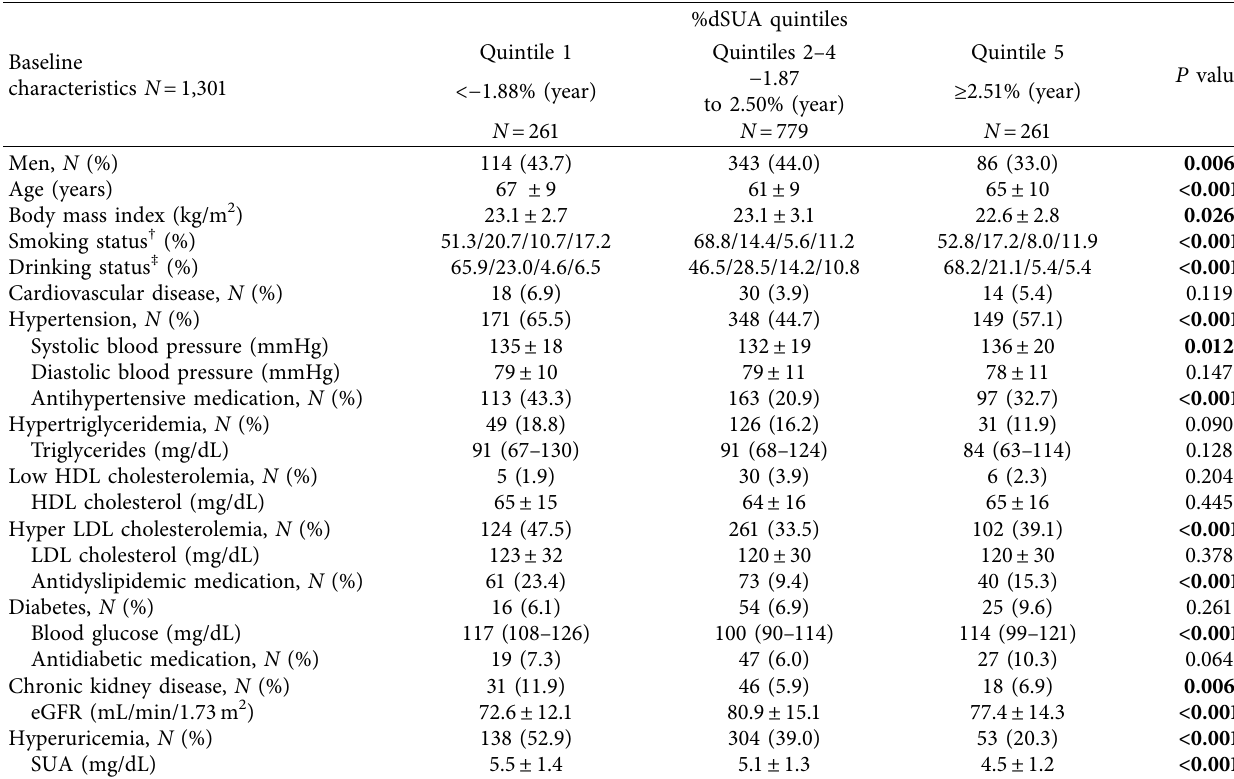
Table 1: Baseline characteristics according to %dSUA